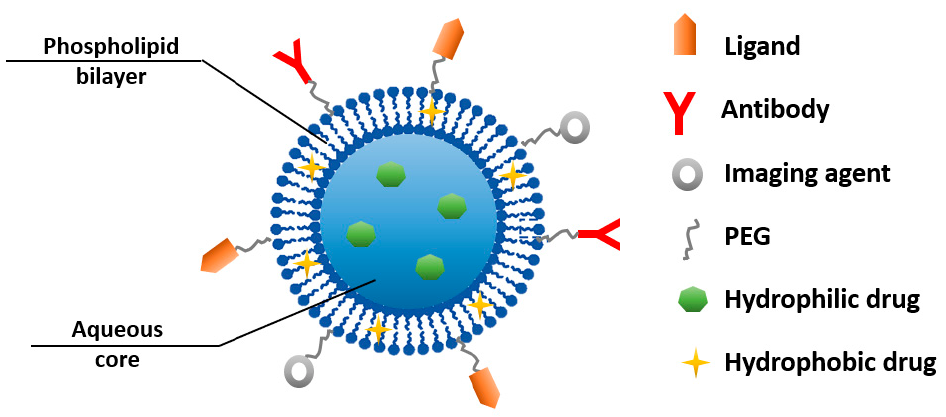
Figure 7. Schematic representation of a multifunctional liposome-based nanoparticle.